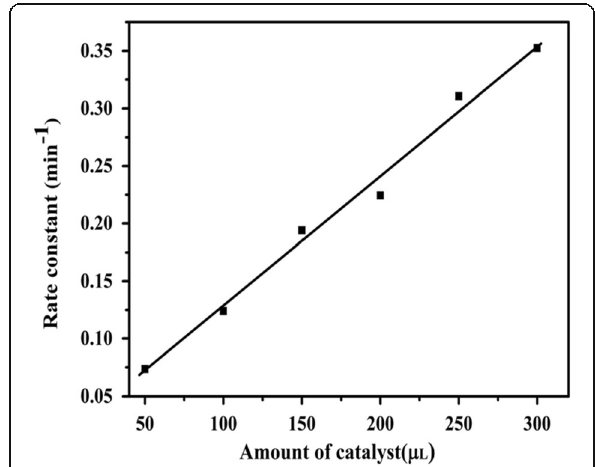
Fig. 11 Plot of rate constant ( k ) versus amount of AuNPs